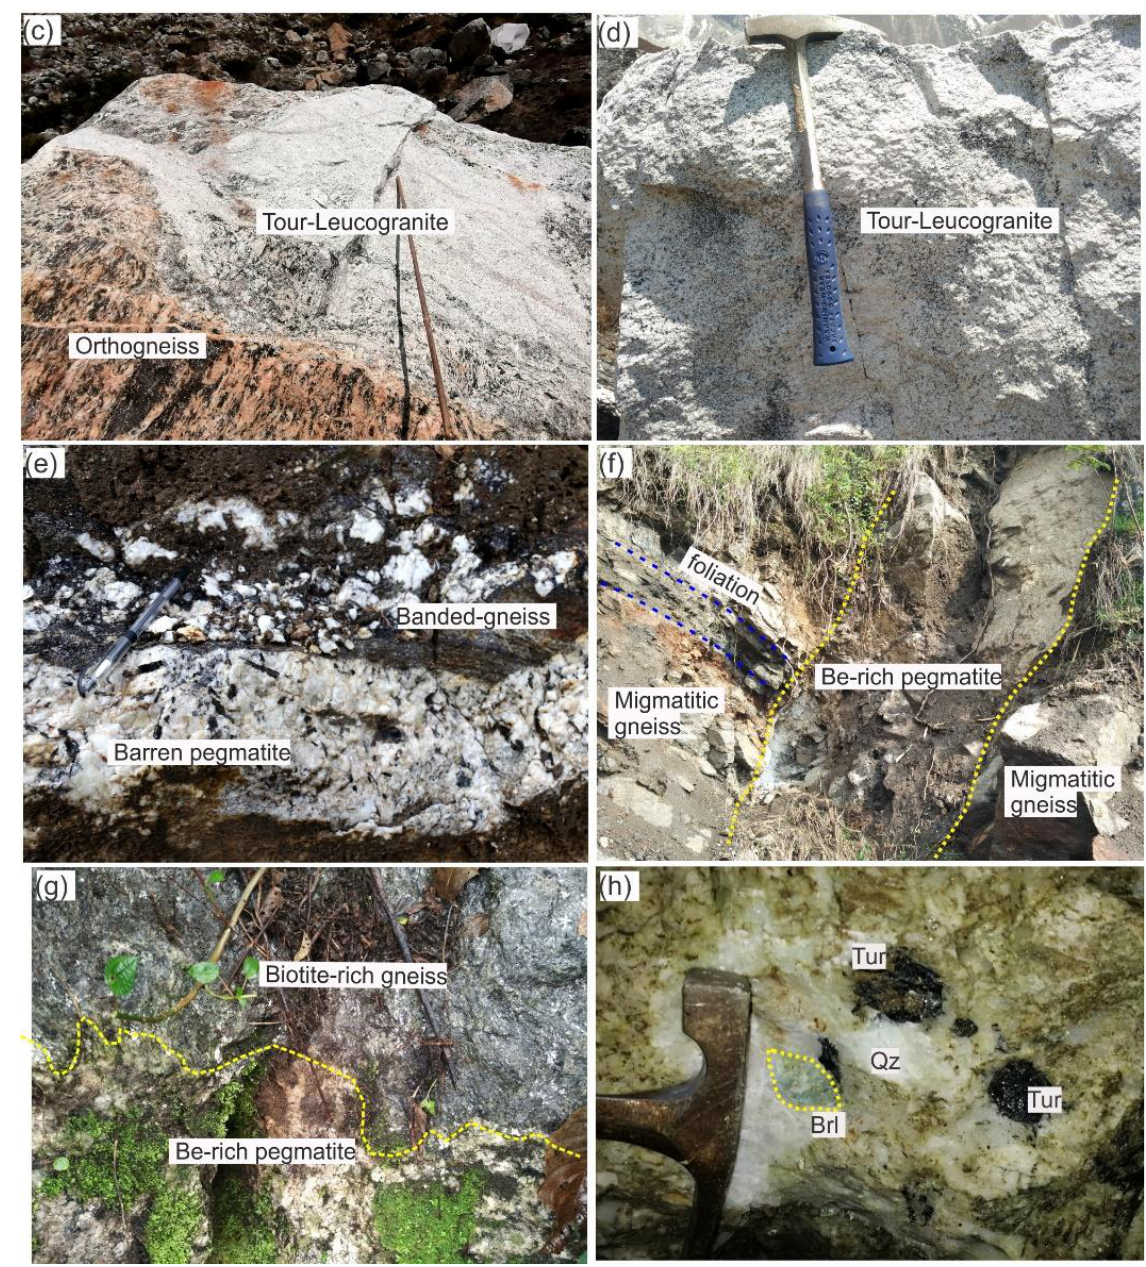
Figure 2. Field photographs of pegmatites and granites. ( a ) Orthogneiss exposure at Lonak (Kanchenjunga area); ( b ) Field view of Kanchenjunga – Jannu leucogranite at Mt. Jannu base camp; ( c ) Tour-leucogranite crosscutting the orthogneiss; ( d ) Tour-leucogranite; ( e ) Barren pegmatite intruded on banded gneiss at Chyanthapu area; ( f , g ) Be-rich pegmatite showing angular and sharp contact with host-rock gneiss at Ikhabu area; ( h ) Beryl seen in the outcrop of Be-rich pegmatite at Ikhabu area. Mineral abbreviations: Brl, beryl; Qz, quartz; Tur, tourmaline. Mineral abbreviations are after [10].